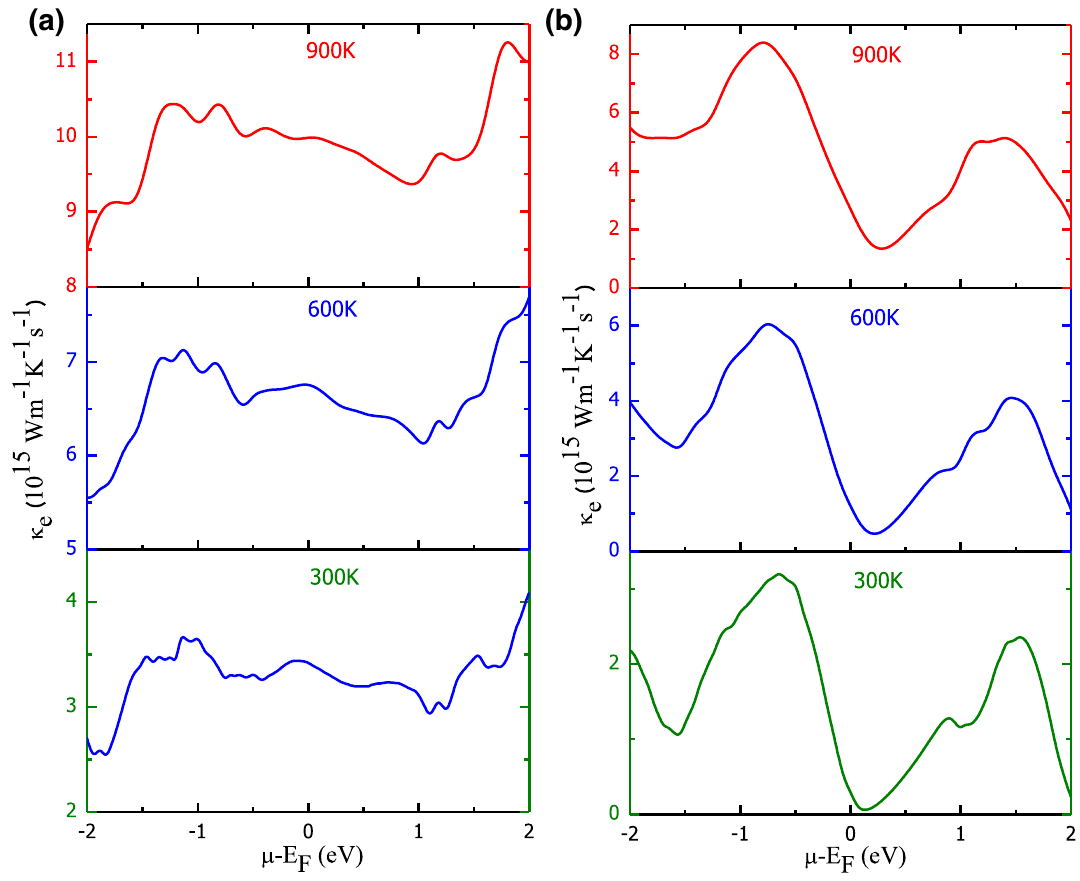
Figure 9. Variation in total electronic thermal conductivity with chemical potential and temperature: ( a ) Ba 2 FeNiO 6 ; ( b ) Ba 2 CoNiO 6